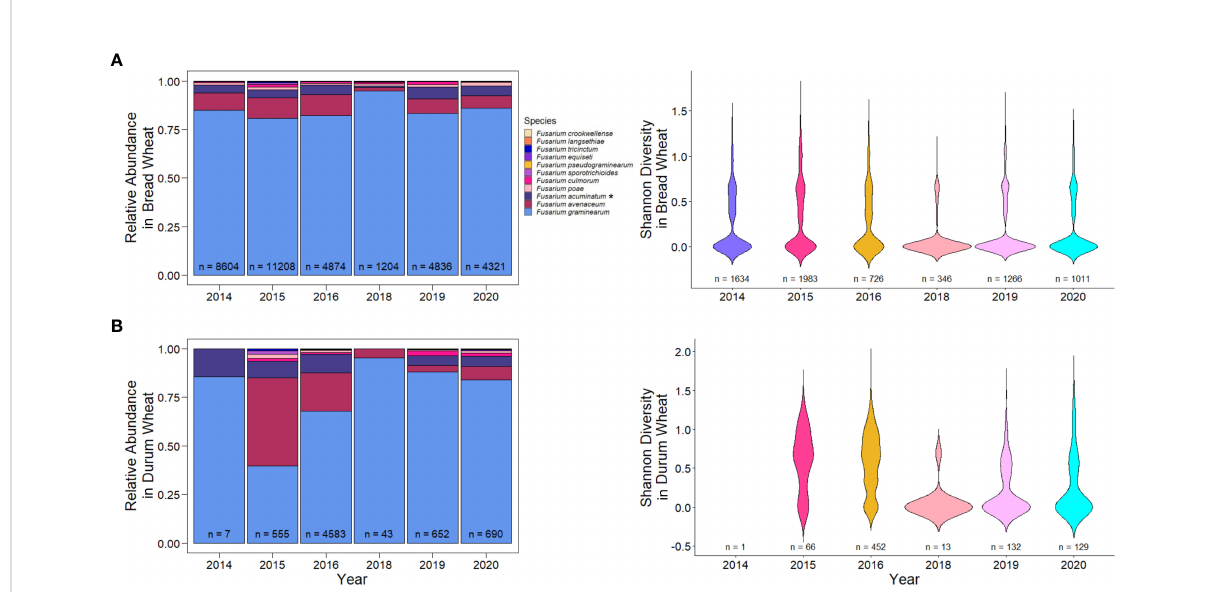
FIGURE 8 Relative abundance and diversity of Fusarium species in (A) hexaploid and (B) durum wheat across years. Asterisks (*) signify putative F. acuminatum